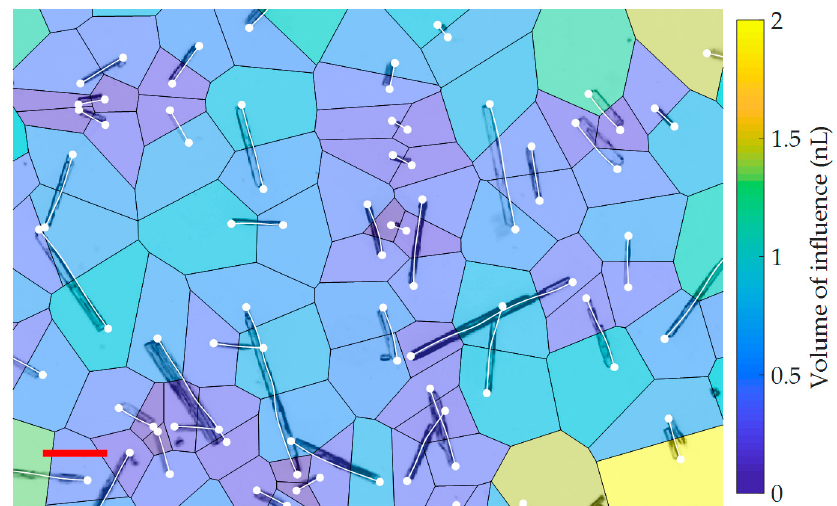
Figure 6. An image of growing crystals is divided into areas based on distance to nearest growing crystal end. The areas are colored based on the volume represented by the area and range from dark blue representing the smallest volume (0.1 nL) and yellow representing the largest volume (2 nL). The areas are overlaid on the grayscale image from which the data were generated. The white points are the crystal ends used in the analysis, and the white curves connecting them illustrate how the crystal is represented in the image analysis program GT Fiber. The red scale bar is 100 μ m.